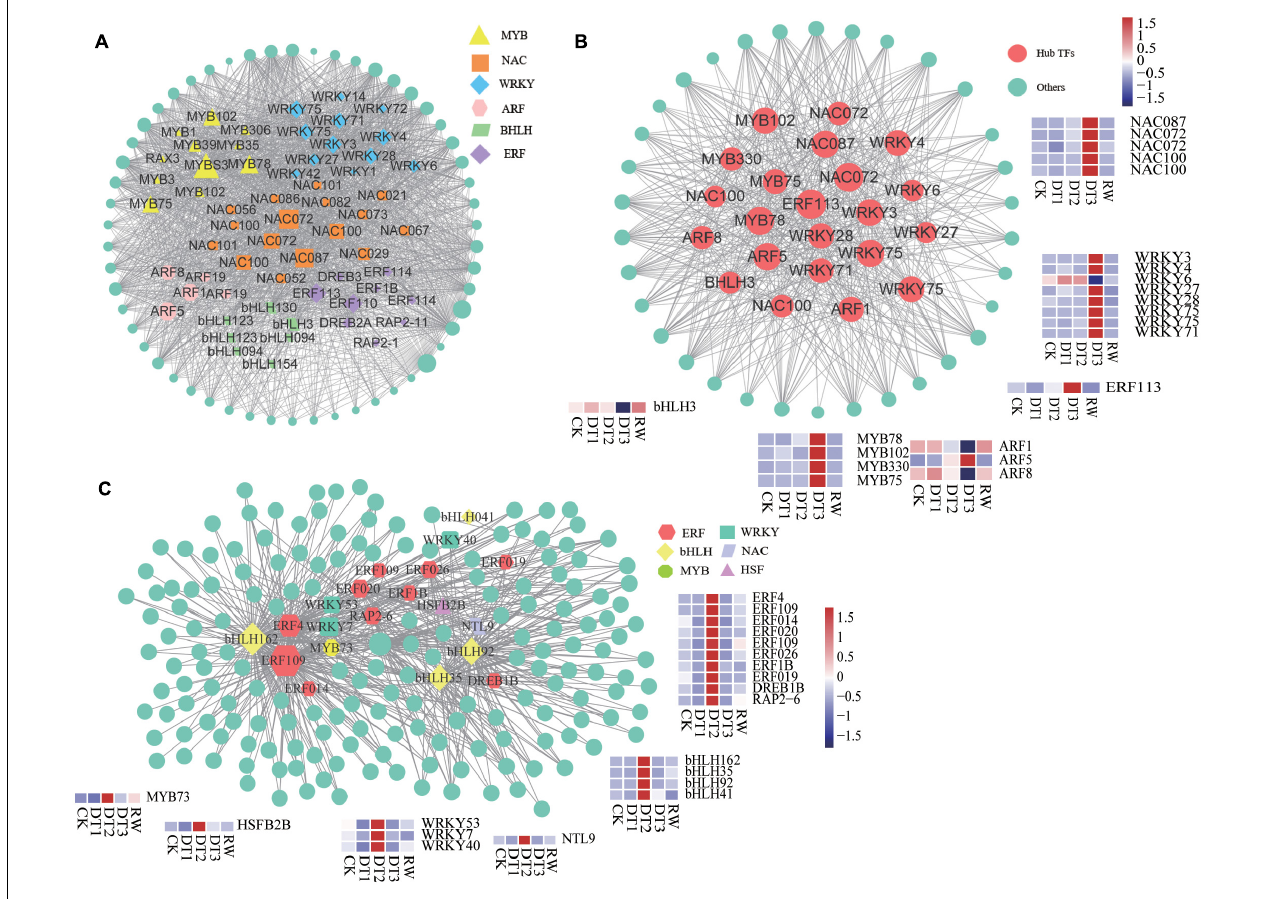
FIGURE 8 | Identification and selection of vital transcription factors in navajowhite1 and blue module. (A) Network analysis of TFs in navajowhite1 module. (B) Network of the top 22 hub TFs and related genes in the navajowhite1 module. (C) Network analysis of hub TFs in the blue